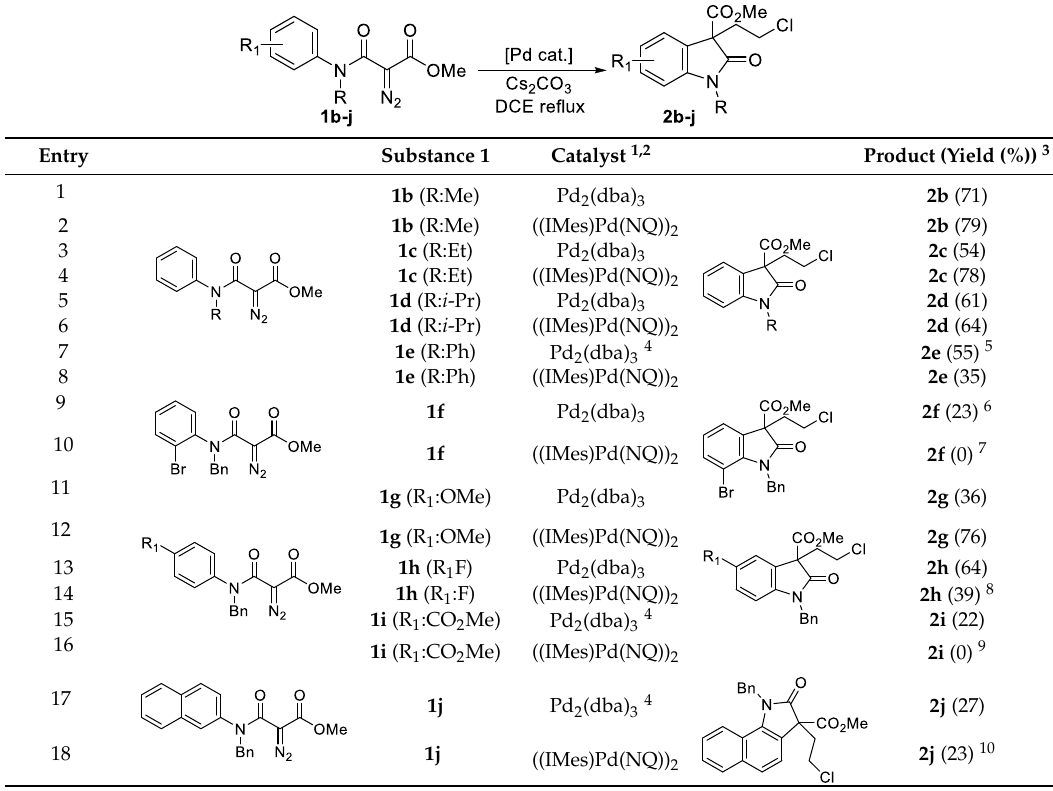
Table 2. Palladium-catalyzed cyclization reactions of α -diazoamides 1b – 1j .